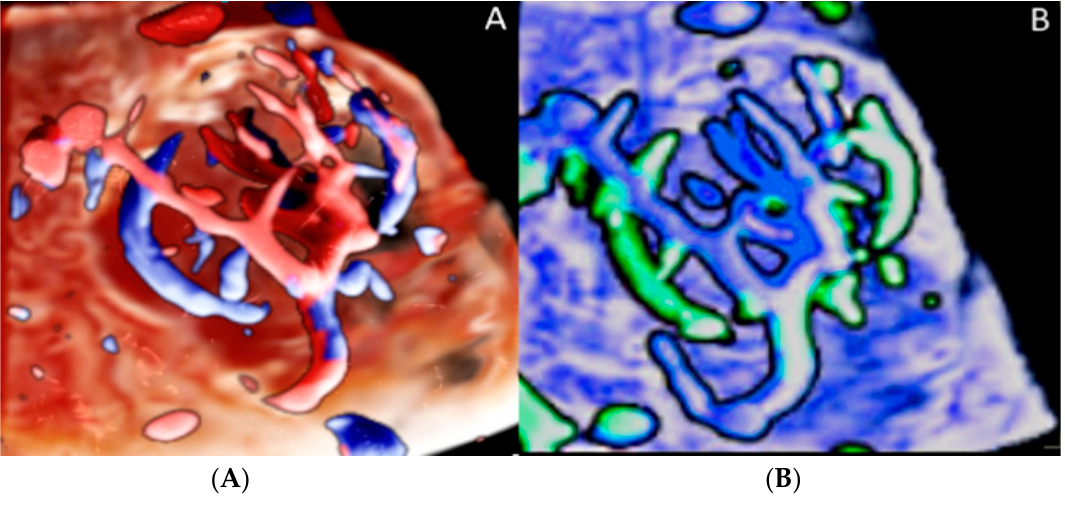
Figure 12. Three-dimensional ultrasound in a case of placental chorioangioma detected using Cristal Vue™ at 31 week’s gestation ( A ). Note the detail of the vascular branching ( B ).